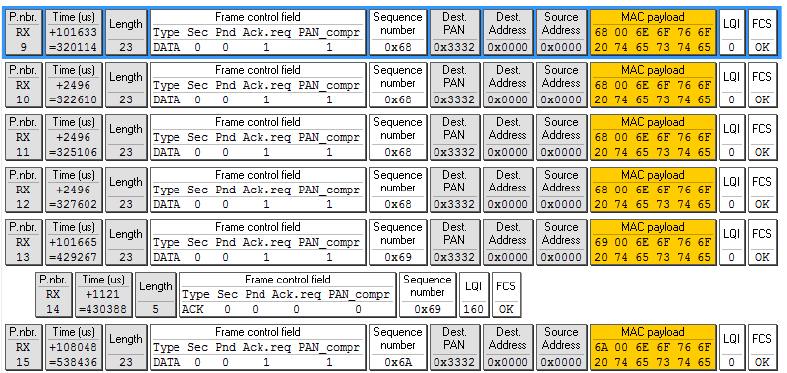
Figure 5. Data analysis by Packet Sniffer.